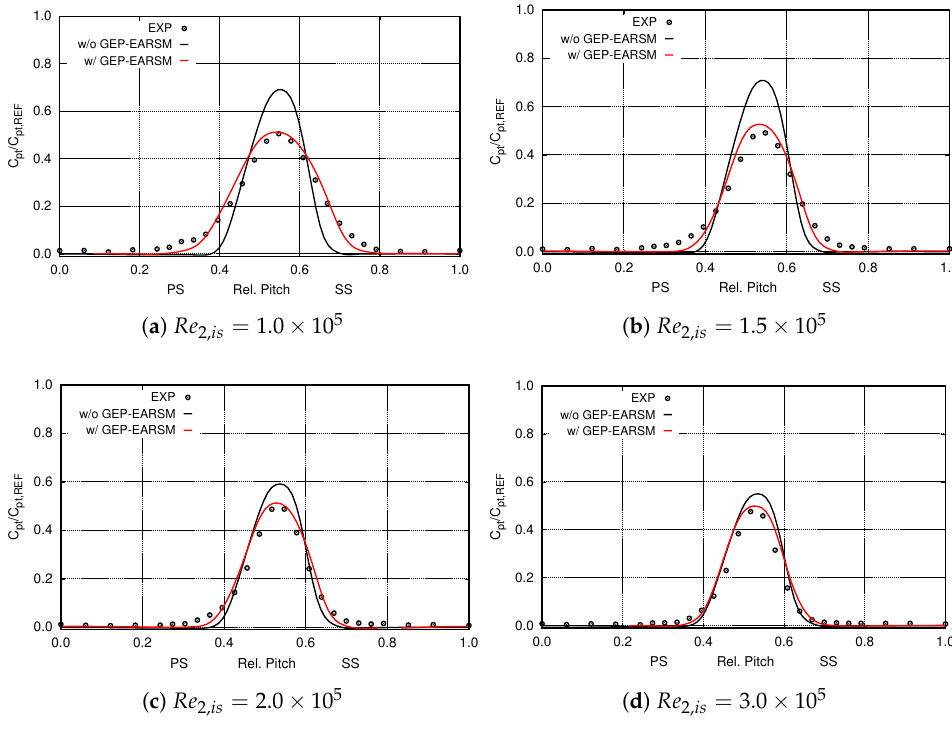
Figure 8. Wake loss profiles ( x / C x , ms =